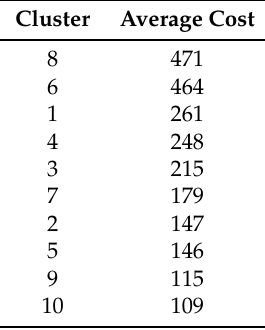
Table 3. Average cost for each cluster of Figure 15b, sorted in decreasing cost order. The clusters with higher costs are 8 and 6, which correspond to the left and bottom areas, respectively.